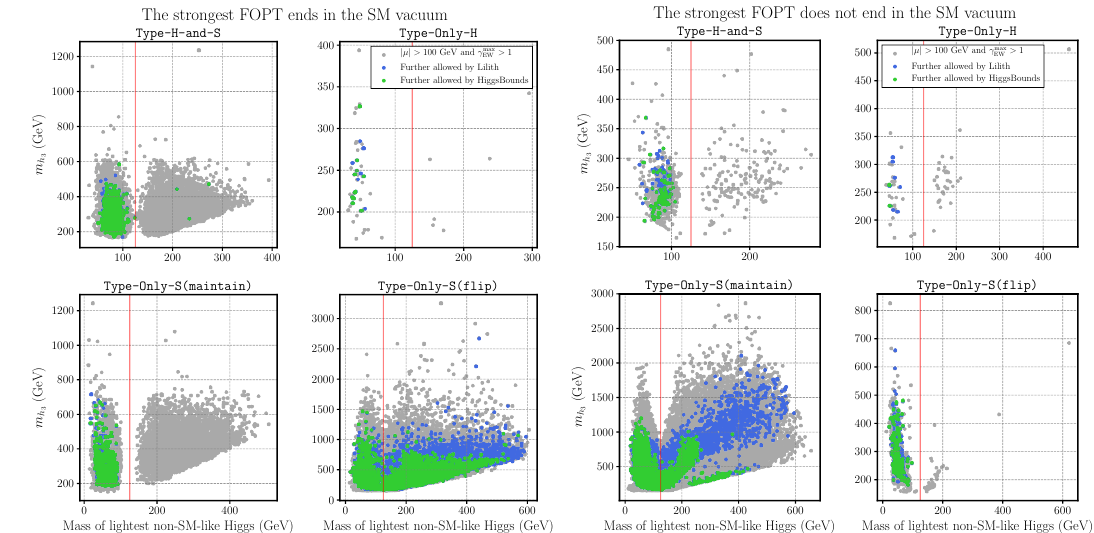
Figure 13 . Masses of the non-SM-like Higgs bosons in our four scenarios, for points for which the strongest FOPT ends in the SM vacuum (left block of four plots) and does not end in the SM vacuum (right block of four plots). We show points satisfying (cid:22) > 100 GeV and (cid:13) EW > 1 (gray), further allowed by Lilith-1.1.4 DB-17.05 [110] constraints on the SM-like Higgs (blue), and by HiggsBounds-5.3.2beta [114{118] constraints on non-SM-like Higgses (green). The vertical red line indicates m h = 125 GeV in each